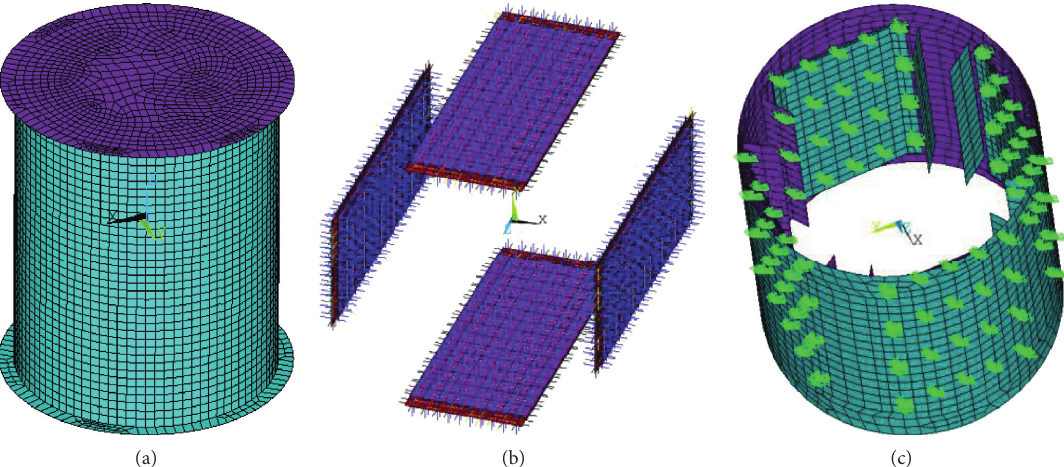
Figure 12: Finite element model and special boundary constraints. (a) Finite element model. (b) Contact pairs on LYP steel plates. (c) Simulation of bolts